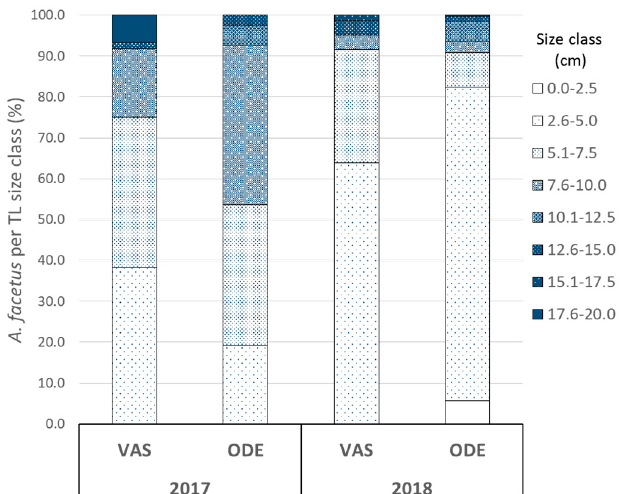
Figure 3. Variation in length distribution of Australoheros facetus in the Vascão (VAS) and Odelouca (ODE) sites collected in the autumn of 2017 and 2018. Values presented are percentages of fish per every 2.5 cm total length size class in relation to the total number of A. facetus collected. TL: total length.